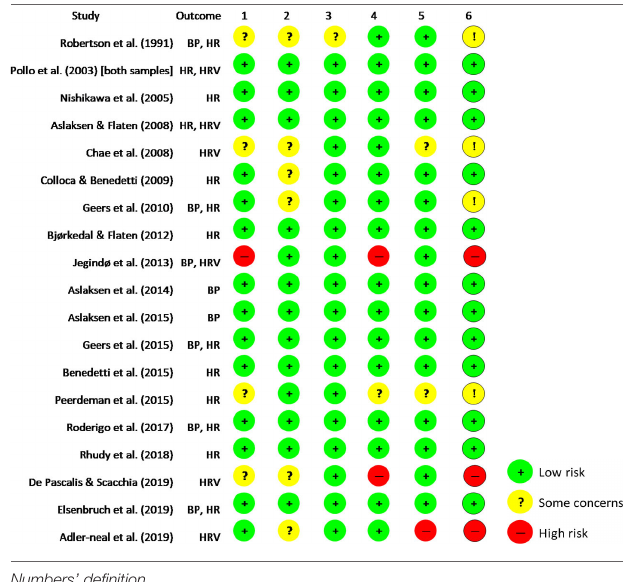
TABLE 3 | Cochrane Risk of Bias tool for the included